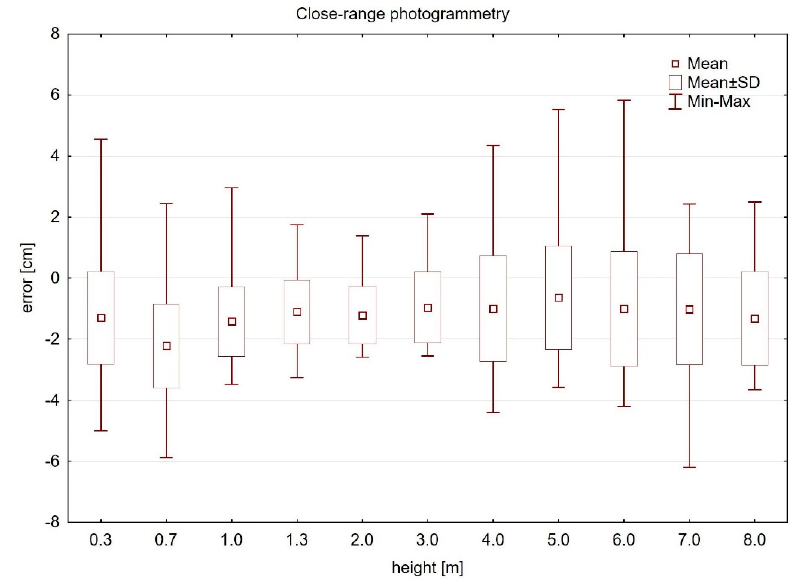
Figure 7. Diameter estimation errors in CRP point cloud cross sections.